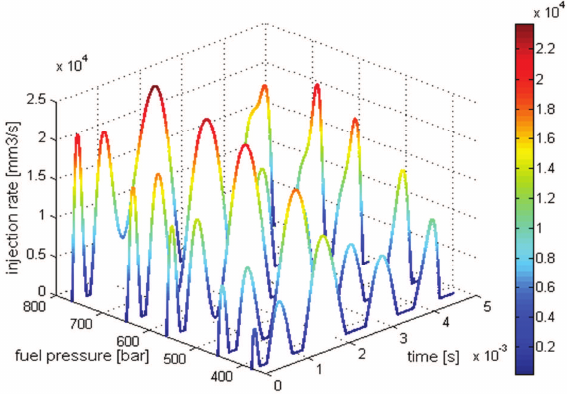
Fig. 3. Injection course of five-portion dose (third measuring group)